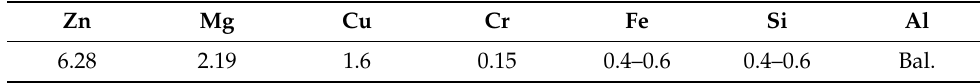
Table 1. Chemical composition of investigated alloys (mass fraction,